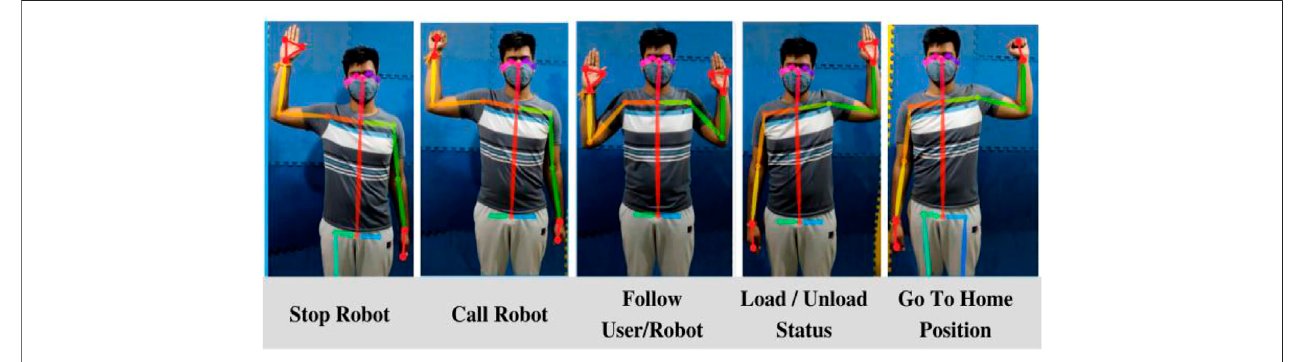
FIGURE 3 | Commands for robot correlating human gestures.